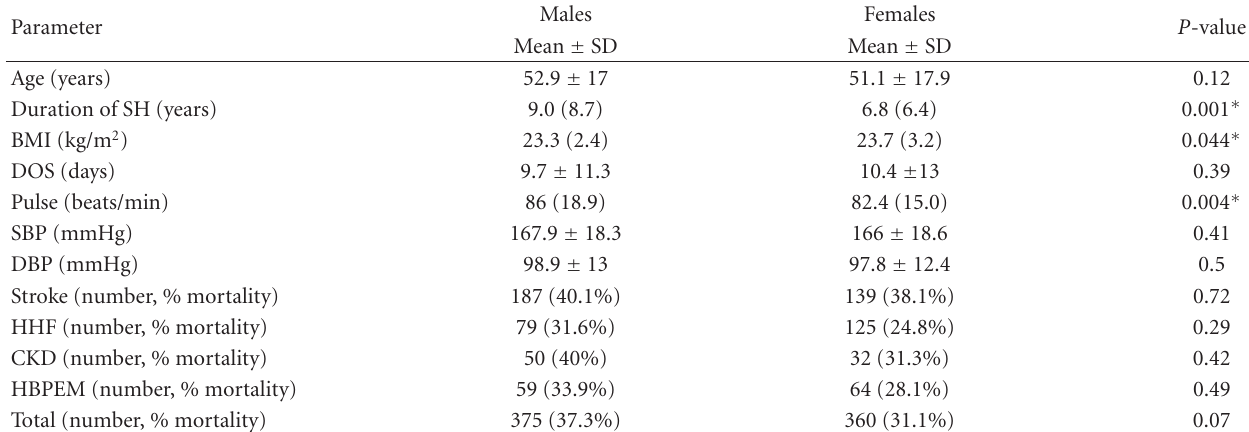
Table 3: Gender di ff erences in mortality of hypertension-related admissions.